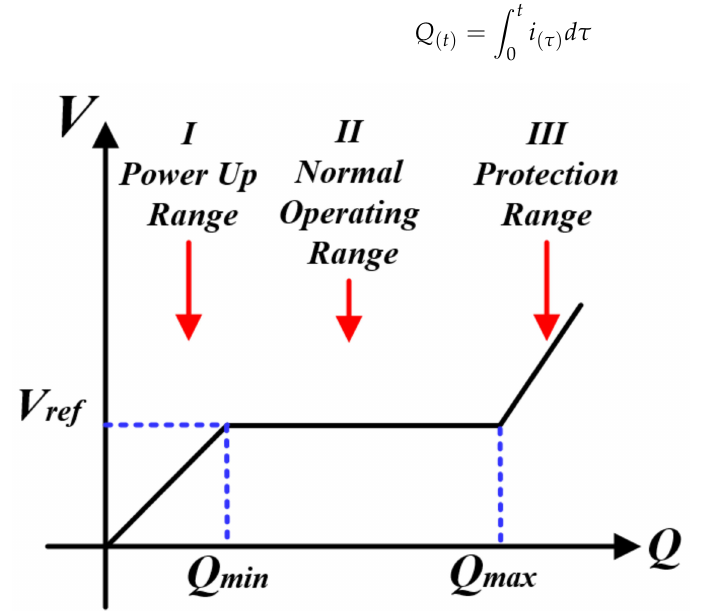
Figure 19. VIC Q–V characteristics. The effective operating range is where Q ∈ [ Q min , Q max ]